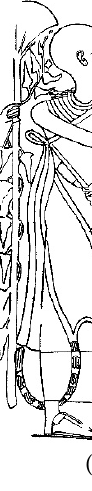
Figure 12. Canine (fox?) engaged in priestly activity (left, whereabouts unknown), ostracon, findspot unknown (said to be from Thebes), Ramesside period. A priest engaged in a similar ritual (right, TT 51), wall painting, Sheikh Abd el-Qurna (Theban necropolis), reign of Seti I (ca. 1290–1279) (Drawings taken from Davies and de Garis 1917, pl. 50) ( a , b ).